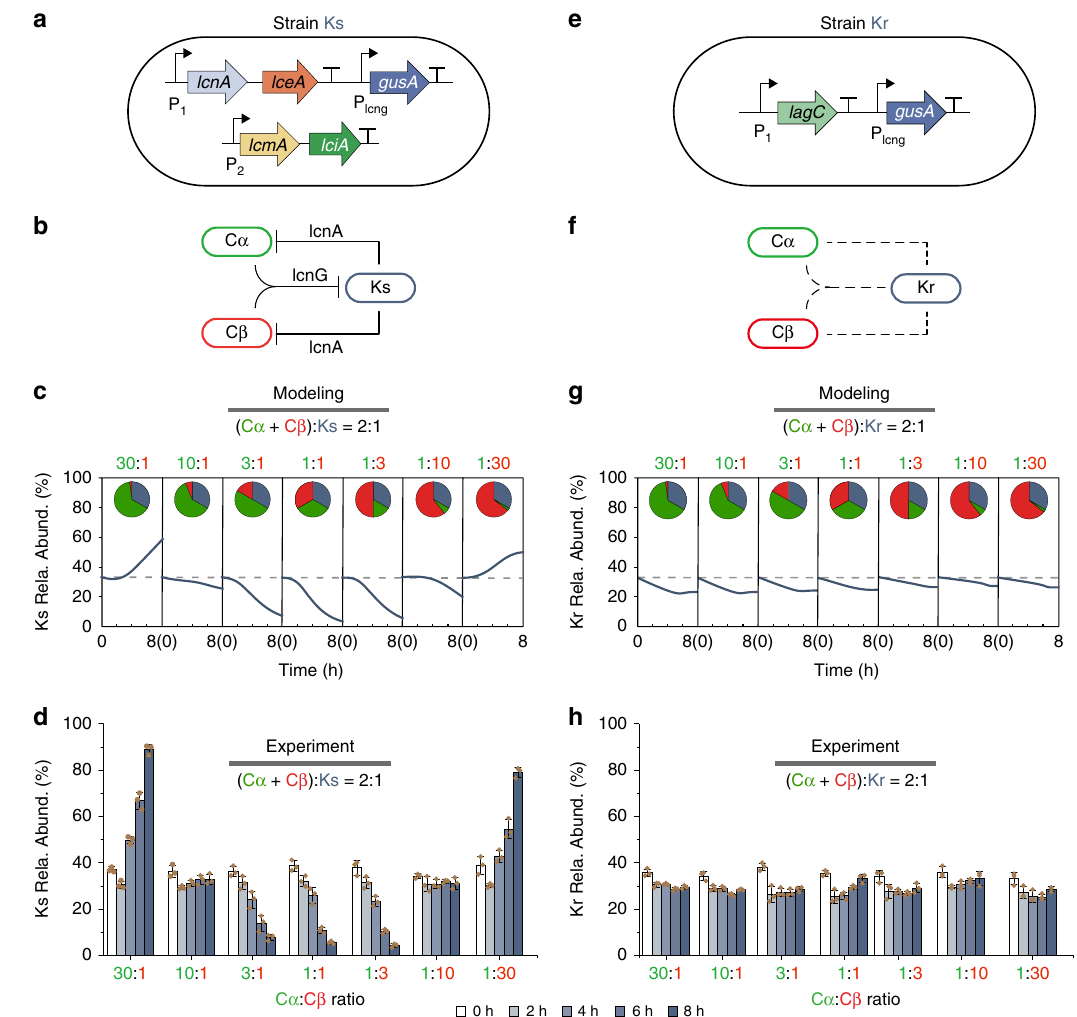
Fig. 3 Succession of a three-strain ecosystem driven by cooperation variations from labor partition. a Design of a competitive third strain Ks. The lcnA biosynthesis pathway, including the genes lcnA, lceA , lciA, and lcmA , is placed under constitutive promoters for constant lcnA secretion. The gene gusA3 is also introduced for colorimetric quanti fi cation. b A three-strain consortium composed of C α , C β , and Ks. C α and C β cooperate to produce lcnG that inhibits Ks; in turn, Ks secrets lcnA to oppose C α and C β . c , d Model-predicted ( c ) and experimentally measured ( d ) temporal dynamics of the Ks abundance in the C α -C β -Ks ecosystem. The initial C α :C β partition was varied across 30:1 to 1:30, but the total (C α + C β ): Ks ratio was fi xed as 2:1. e Design of a control strain Kr. L. lactis MG1363 is loaded with the constitutively expressed lagC , the lcnG immunity gene, to confer resistance to lcnG and gusA3 for colorimetric quanti fi cation. f A three-strain ecosystem composed of C α , C β and Kr. As Kr is de fi cient in lcnA production but resistant to lcnG, the consortium does not have active bacteriocin-mediated interactions. g , h Model predictions ( g ) and experimental measures ( h ) of temporal dynamics of the Kr strain in the C α - C β -Kr ecosystem. The initial C α :C β partition was varied across 30:1 to 1:30, but the total (C α + C β ): Kr ratio was fi xed as 2:1. Source Data available in the source data fi